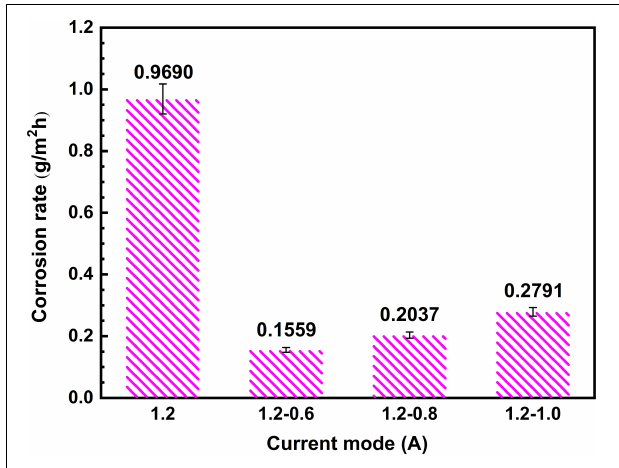
FIGURE 8 | Corrosion rate of MAO coatings under different current